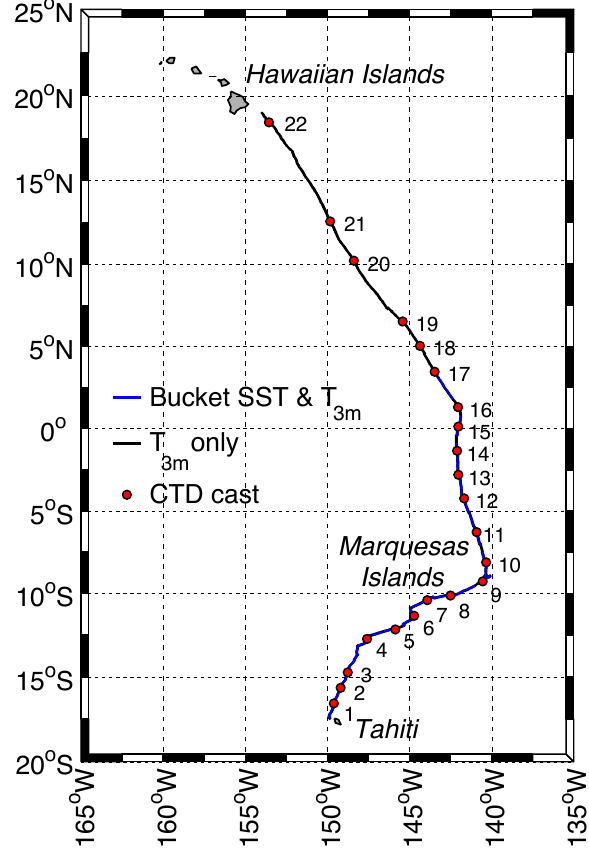
Fig. 1. Map of the cruise transect across the central tropical Pacific. The blue line denotes the portion of the transect where both bucket and 3m thermosalinograph temperatures ( T 3m ) were observed. The black line denotes the portion of the transect where bucket mea- surements were not taken. Locations of CTD casts are marked by red